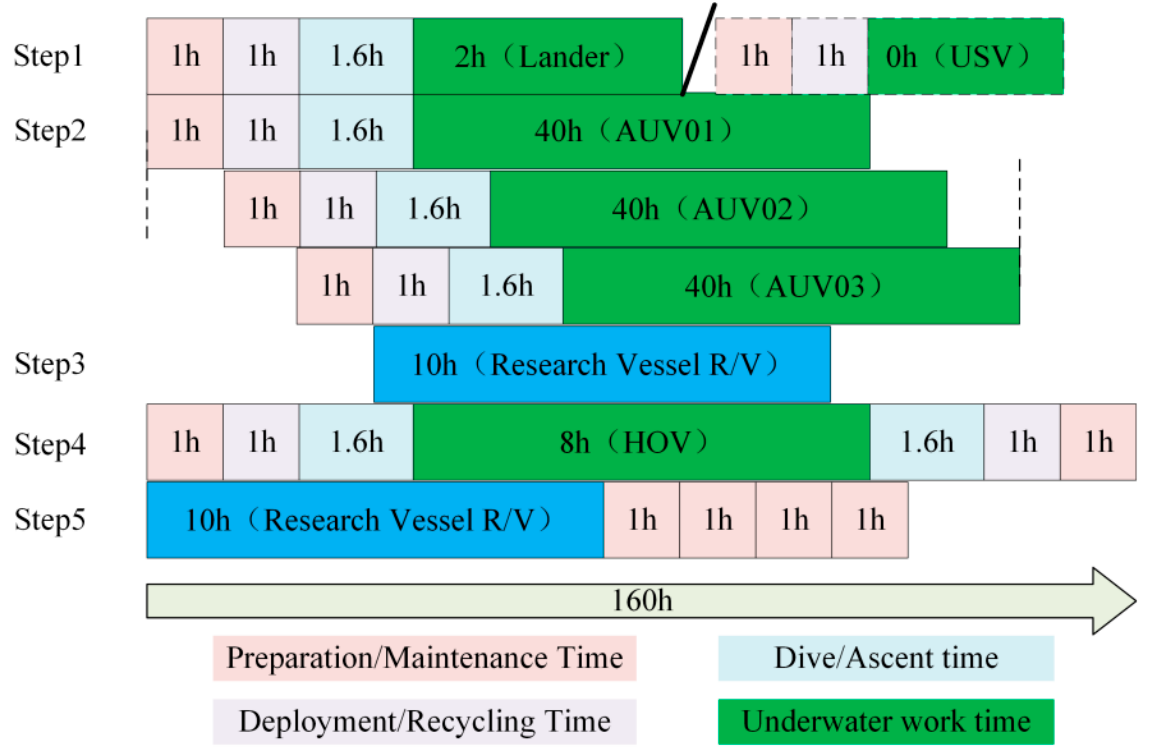
Figure 14. Elapsed time in cooperative operational mode based on a lander/USV.